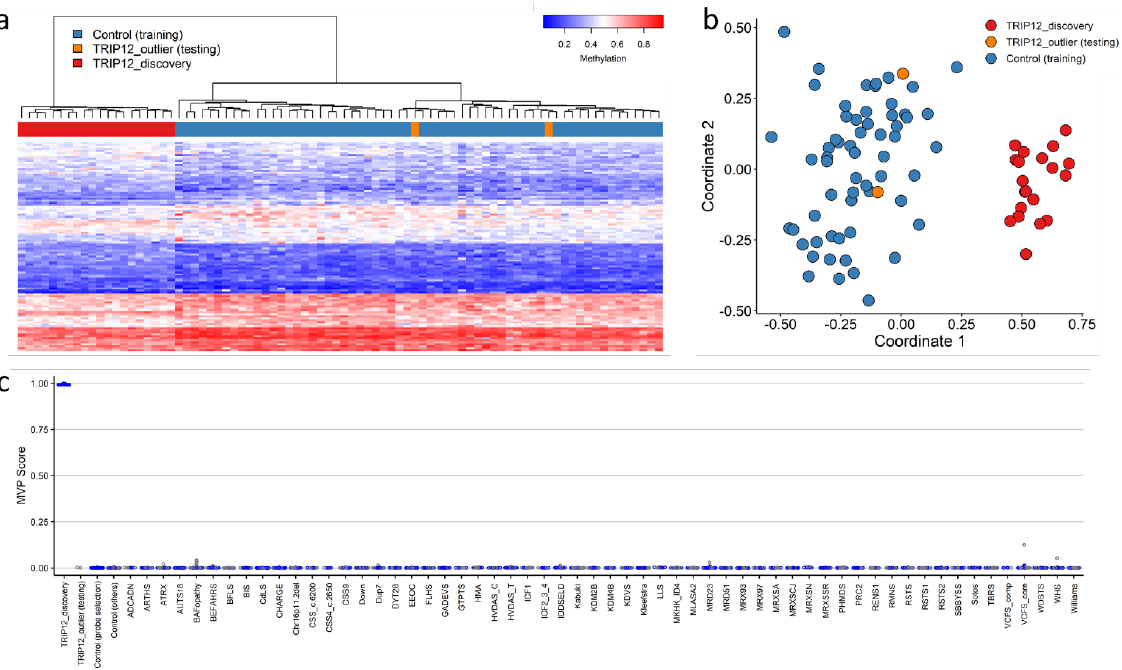
Figure 3. Clark–Baraitser syndrome (TRIP12) episignature—discovery cohort: ( a ) Euclidean hierarchical clustering (heatmap): each column represents a single TRIP12 discovery case or control; each row represents 1 of the 105 CpG probes selected for the episignature. This heatmap shows clear separation between 20 TRIP12 cases (red) from controls (blue). Two outlier cases (orange) are shown to segregate with controls; ( b ) Multidimensional scaling (MDS) plot shows segregation of TRIP12 cases from both controls and outlier cases; ( c ) Support Vector Machine (SVM) classifier model. The model was trained using the 105 selected TRIP12 episignature probes, 75% of controls and 75% of other neurodevelopmental disorder samples (blue). The remaining 25% controls and 25% of other disorder samples were used for testing (grey). Plot shows the TRIP12 discovery cases with a methylation variant pathogenicity (MVP) score close to 1 compared with all other samples, showing the specificity of the classifier and episignature.